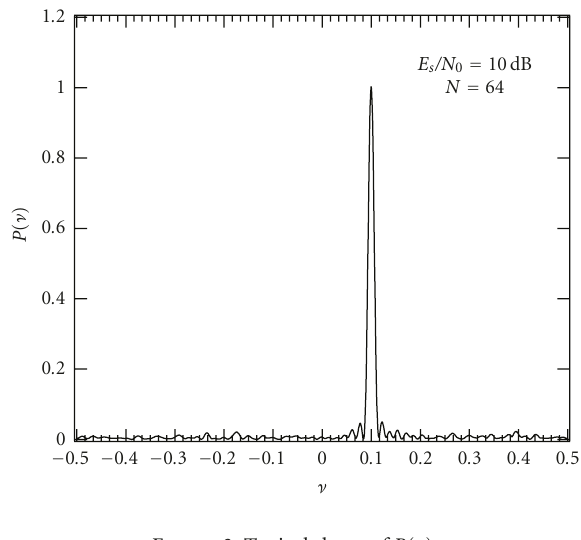
Figure 3: Typical shape of P ( ν